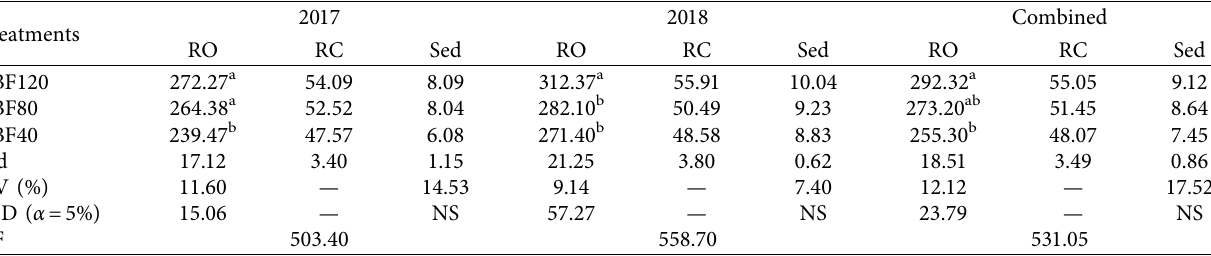
Table 2: Rainfall (mm), runoff (mm), runoff coefficient (%), and sediment yield analysis results during the growing periods with their combined mean.